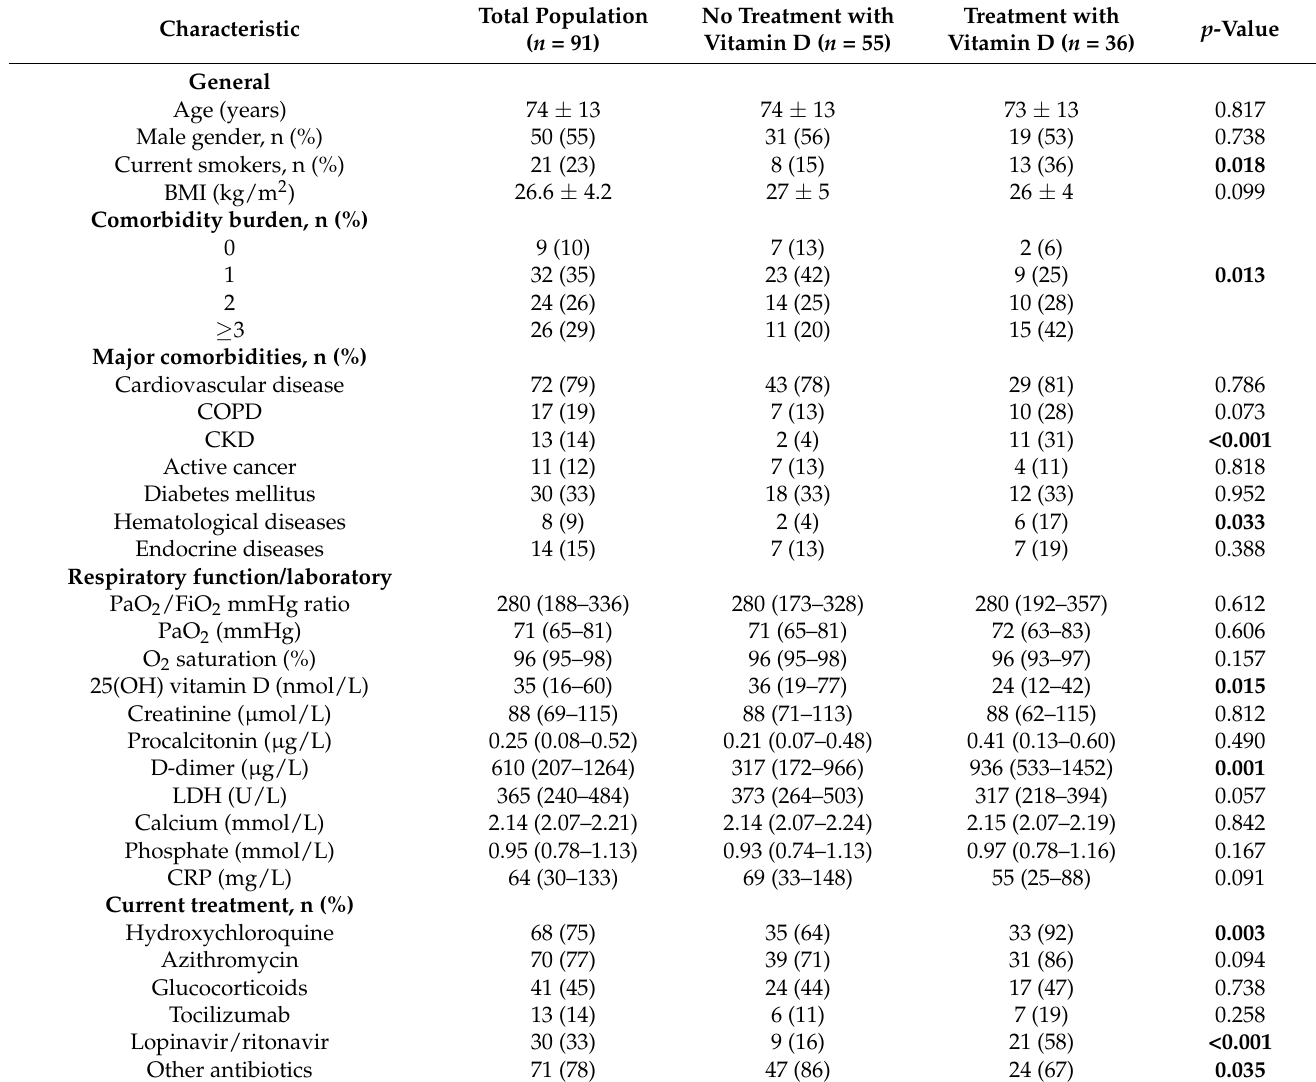
Table 1. Patient characteristics stratified by treatment with vitamin